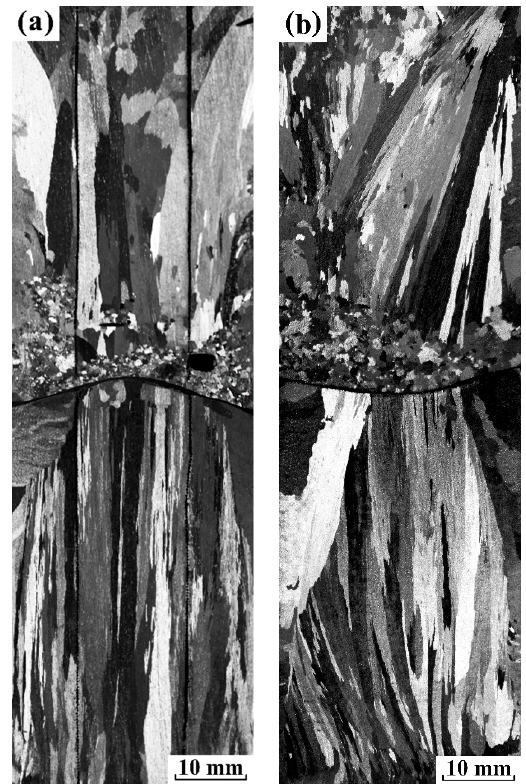
Figure 7. The solidification macrostructure along the longitudinal section of pure aluminum ingots under electropulsing with 480 A with a mold of 34 mm embedded the metal mesh: ( a ) a mesh plate located in the middle of mold and two mesh tubes embedded along axis and ( b ) a mesh plate placed in the middle of mold.